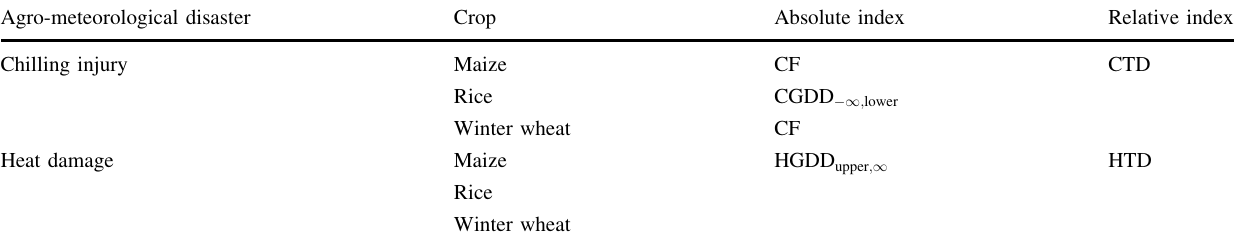
Table 2 Temperature-related agricultural disaster index for the three main crops (maize, rice, and wheat) in China Agro-meteorological